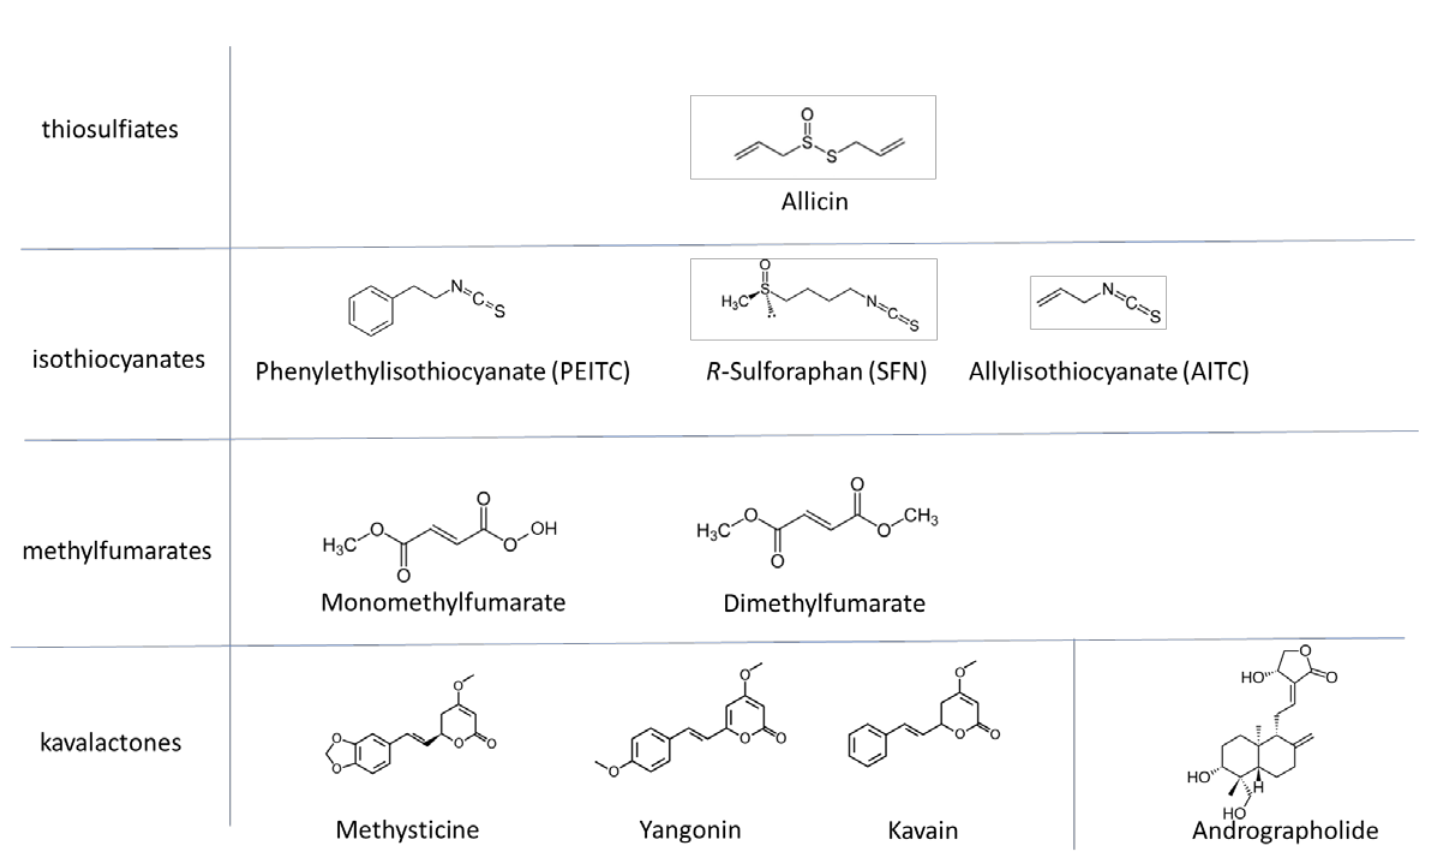
Figure 4. Overview of the chemical structure of the tested compounds. The compounds can be roughly divided into five chemical groups. Allicin belongs to the thiosulfinates, which are typical for representatives of the genus Allium . The isothiocyanates AITC, PEITC, and sulforaphane belong to the isothiocyanates and are mainly found in the Brassicaceae family. Methyl fumarates are esters of fumaric acid and are synthetic in nature. All these compounds have a thiol reactivity in common. The kavalactones (methysticin, yangonin, kavain) and the diterpene lactone andrographolide are derived from the plant Piper methysticum G. Forst and activate the Keap/Nrf2 system in a non-oxidative way.